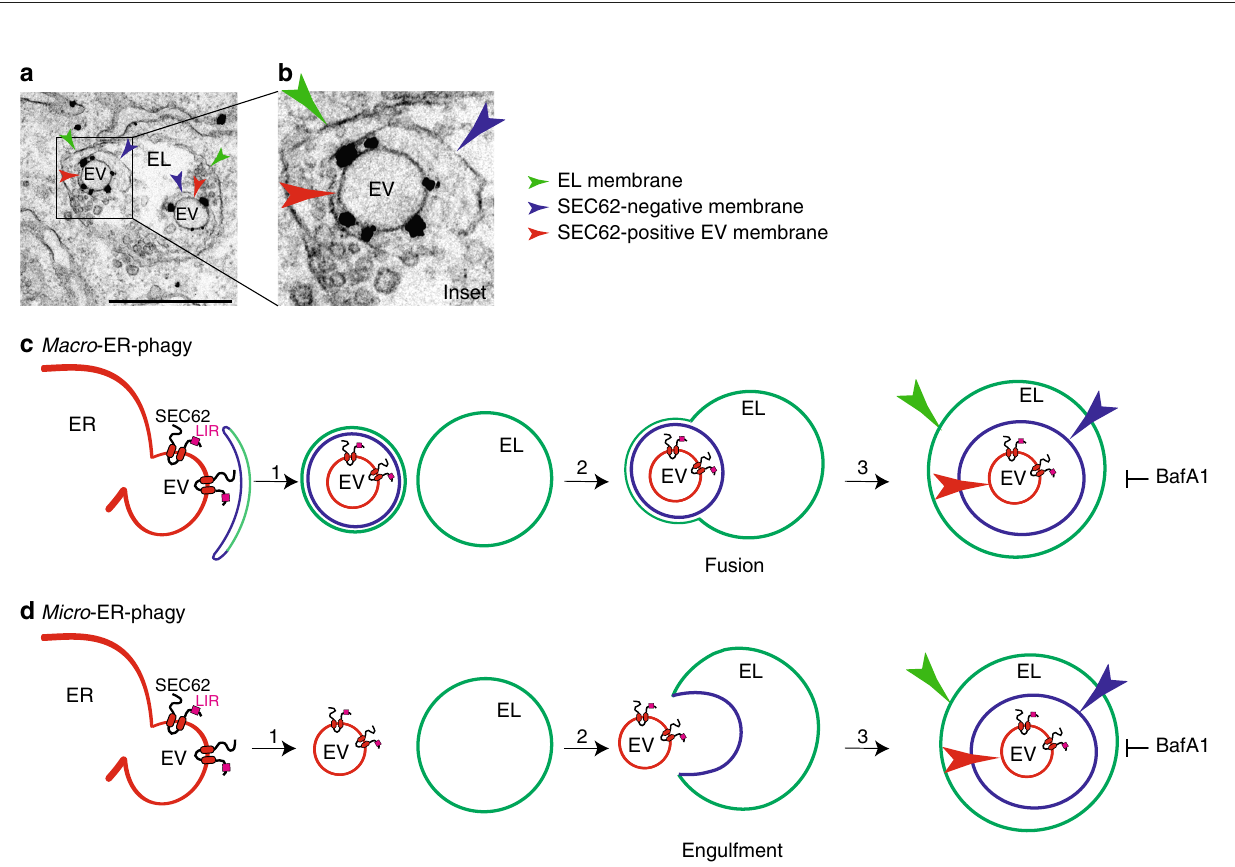
Fig. 2 Distribution of gold-labeled, endogenous SEC62 by IEM. a WT MEFs are exposed 12 h to 10 μ M CPA. Recovery is initiated on CPA wash-out and progresses for 12 h in the presence of 50 nM BafA1 to inhibit clearance of EV delivered within EL. b Inset of a . IEM images are representative of two independent experiments with similar results. c Macro-ER-phagy pathway. d Micro-ER-phagy pathway. EV, ER-derived vesicle; EL, endolysosome; LIR, LC3- interacting region. Color code of arrows is given in the panels. Scale bar for IEM: 1 μ (Fig. 5b – d) and when recov-ER-phagy is recapitulated by SEC62 induction (Fig. 5e – g). Consistently, CHMP4B silencing delays return of ER stress-induced chaperones at their pre-stress level (Fig. 5h, upper panel), without affecting return of HERP (middle panel).